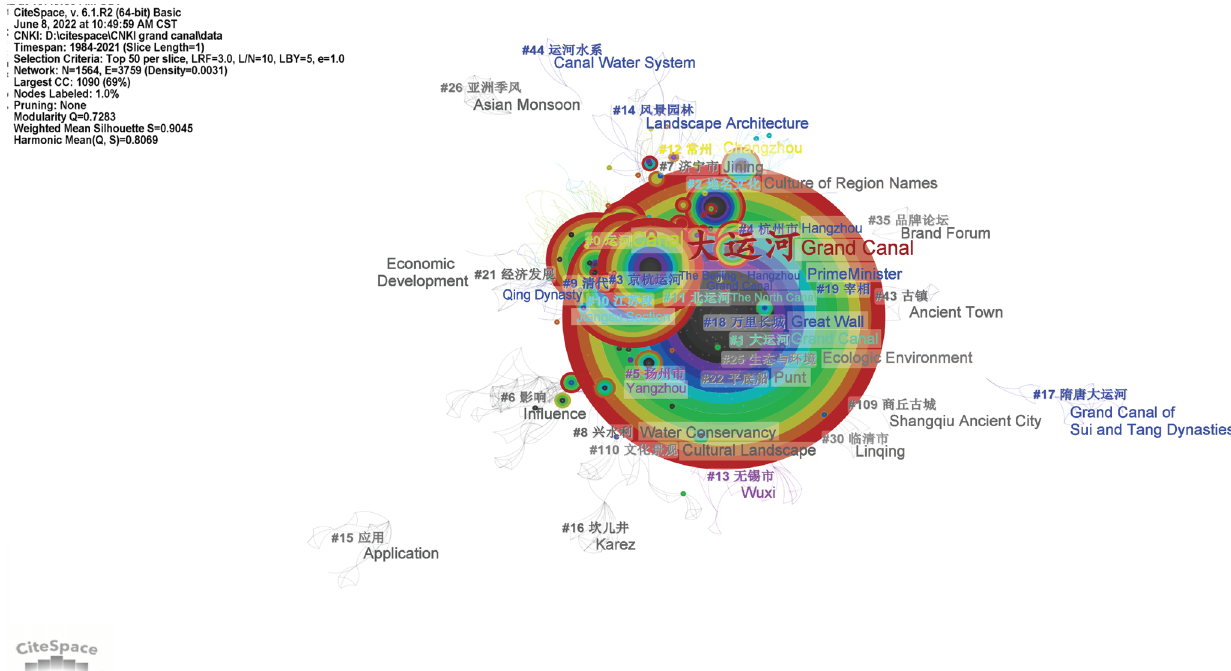
Fig. 8 Keywords and knowledge clusters of Grand Canal of China literatures in CJFD databases (1984 – 2021).